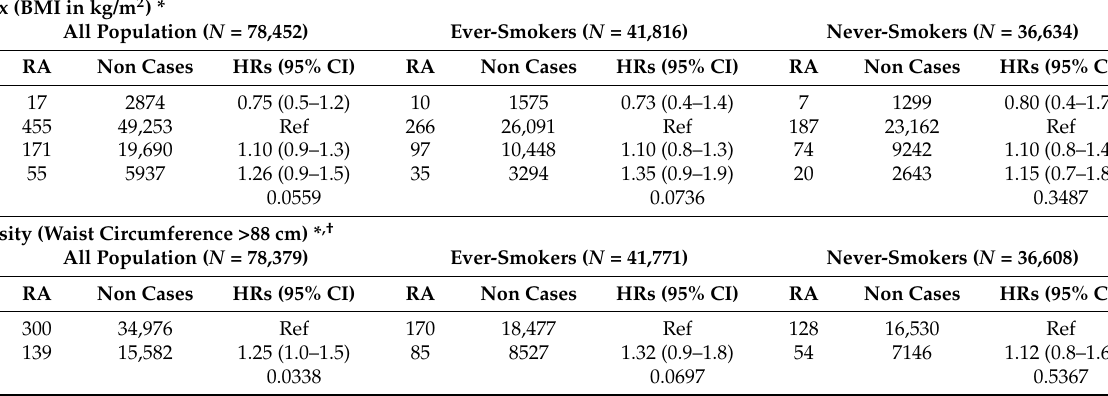
Table 1. Hazard ratios (95% confidence intervals) for the risk of RA by BMI and abdominal obesity in multi-adjusted model (for the overall population, ever-smokers, and